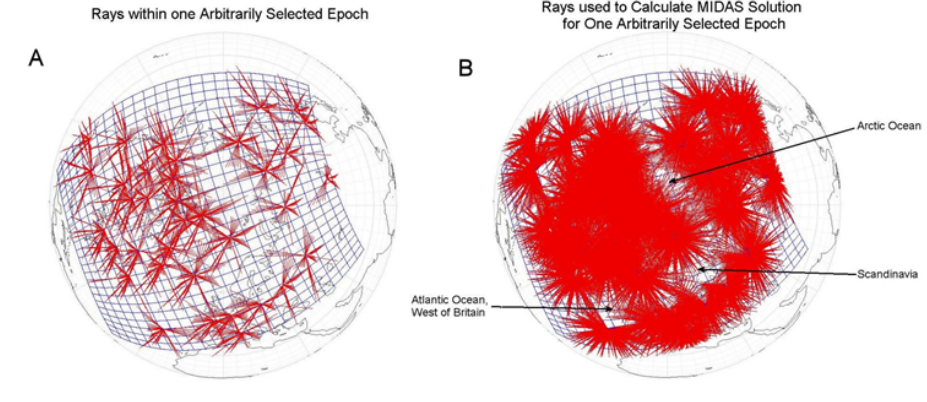
Fig. 2. (a) shows the rays present in one arbitrarily selected 10 min MIDAS inversion epoch. (b) shows all rays used to calculate the solution for this epoch, totalling 150min of data. Note that the areas with the weakest ray coverage are over water.